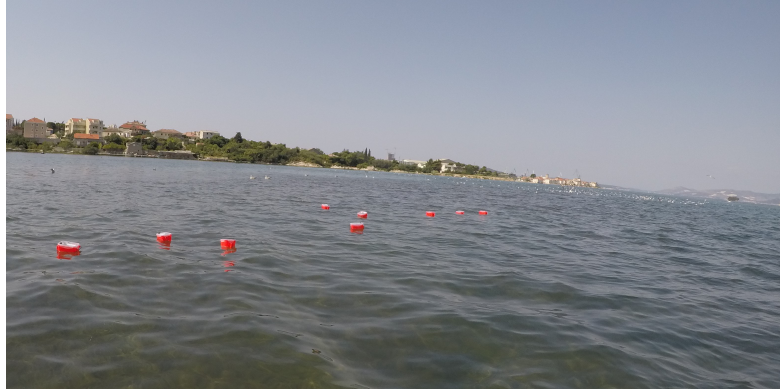
Figure 3. Second release of the probes (photo taken from the